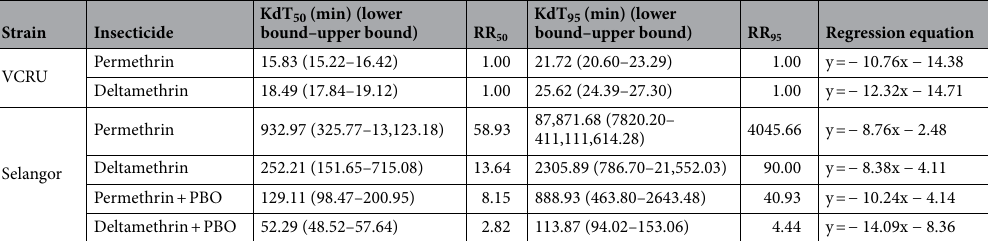
Table 1. Knockdown time (min) KdT 50 and KdT 95 of 1-h exposure time towards two different types of WHO insecticide treatments (permethrin 0.75% and deltamethrin 0.05%) and PBO synergist against Aedes aegypti female adults for susceptible VCRU lab strain and Selangor field strain. KdT 50 knock down times required to kill 50% of the population exposed, KdT 95 knock down times required to kill 95% of the population exposed.